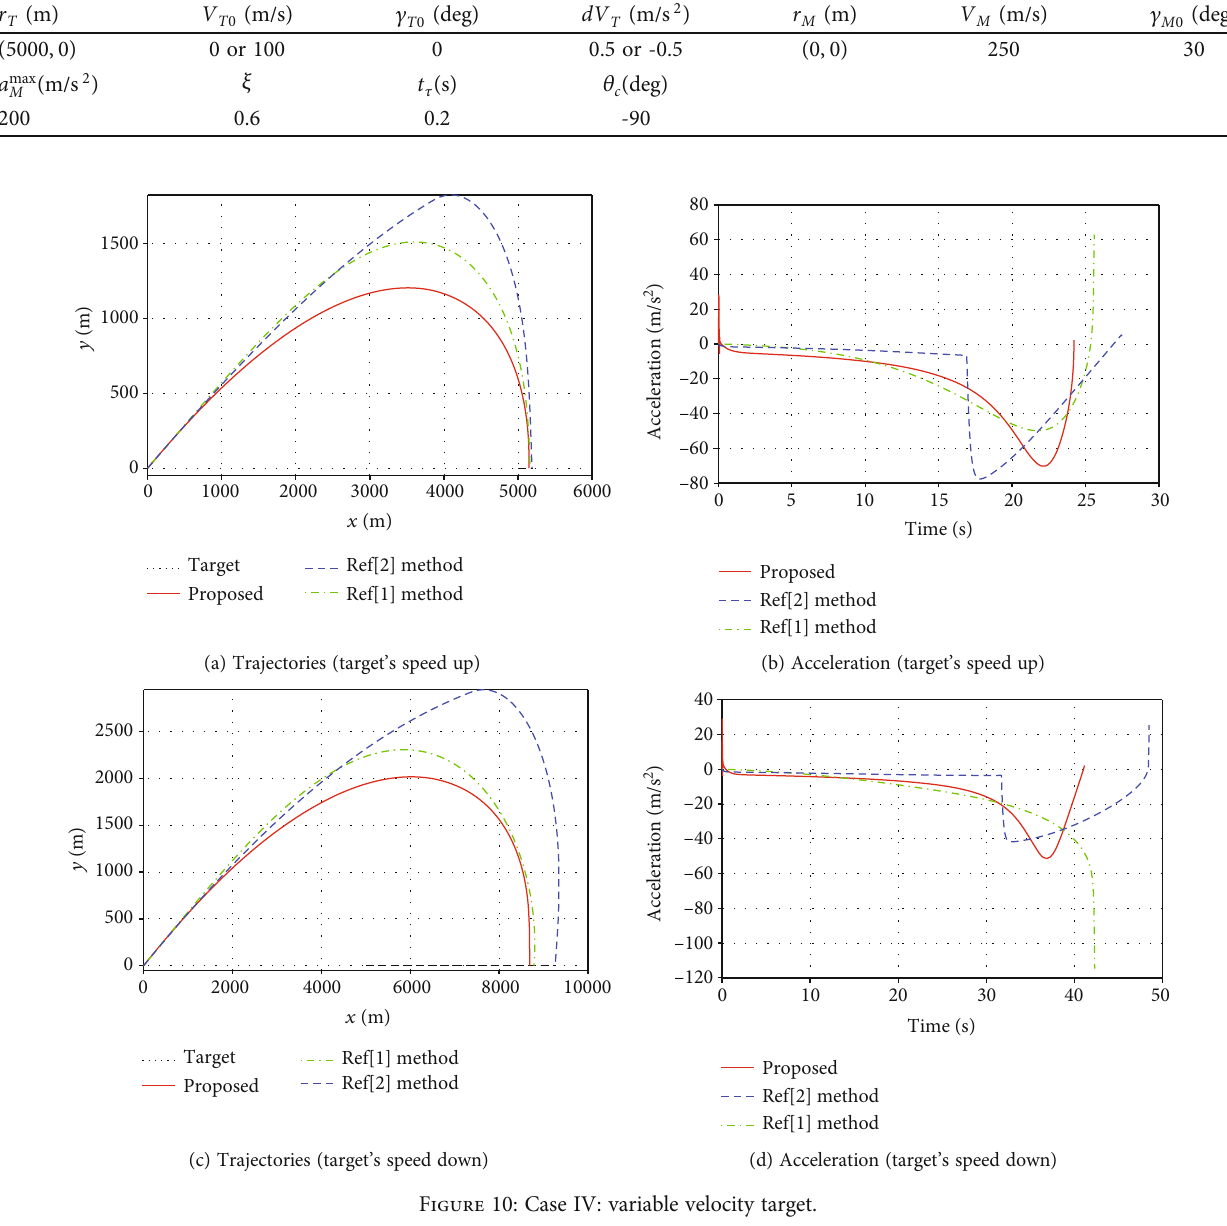
Figure 10: Case IV: variable velocity target.